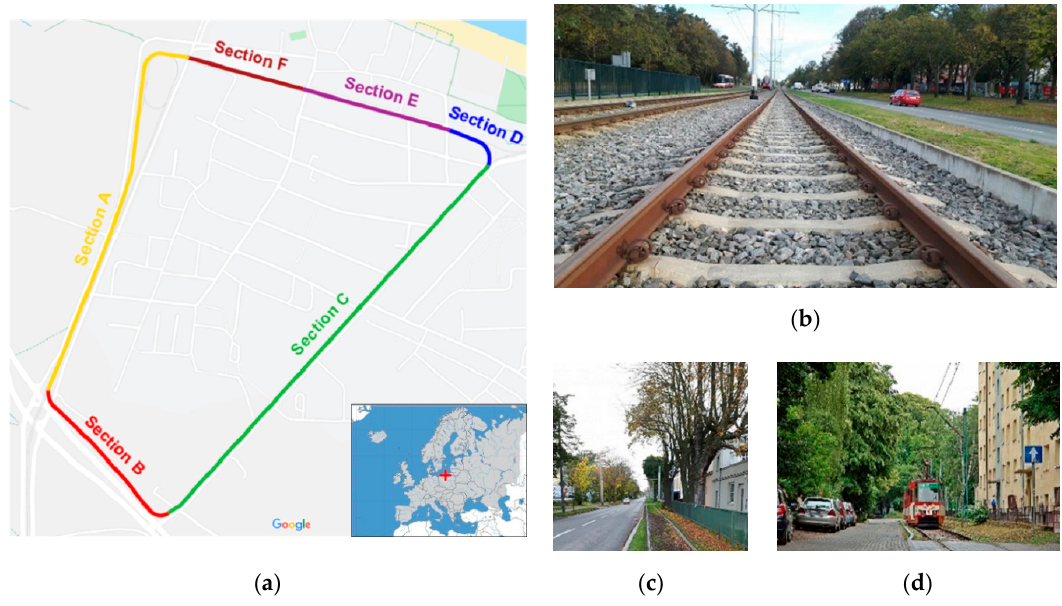
Figure 4. The layout of the test loop ( a ) divided into different measurement sections: sections A and B—open area ( b ), sections C and F—typical urban development ( c ) and densely built-up sections D and E ( d ).